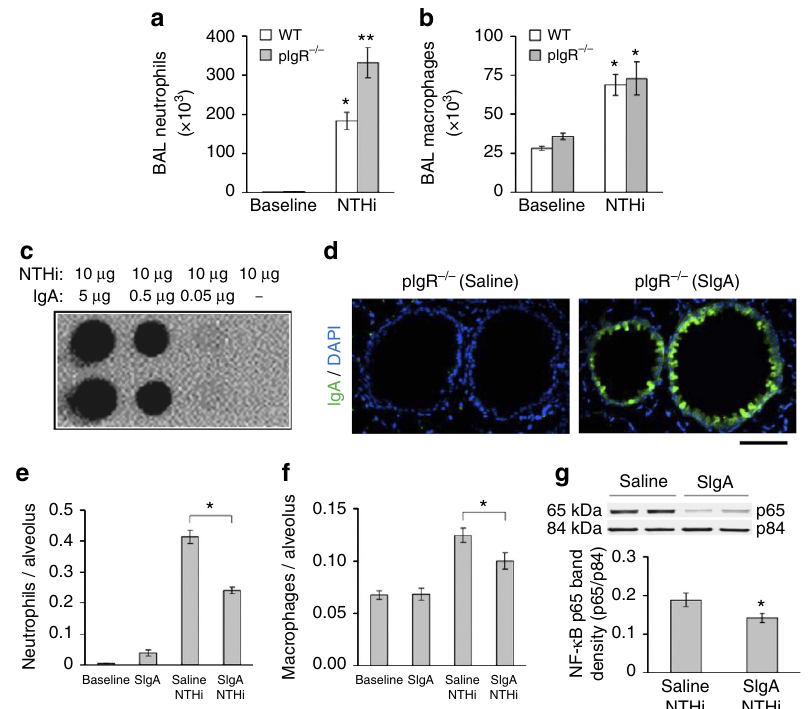
Figure 4 | SIgA modulates the acute inflammatory response to NTHi in vivo . ( a , b ) Neutrophil and macrophage counts in BAL fluid from 2-month-old WT and pIgR (cid:2) / (cid:2) mice 24h after aerosolization of NTHi lysate (10mg). Six to eight mice per group; * P o 0.01 compared with untreated mice (baseline), ** P o 0.01 compared with WT mice treated with NTHi (Student’s t -test). ( c ) Dot-blot assay demonstrating protein binding between NTHi lysates and human SIgA from colostrum. ( d ) Immunofluorescent detection of human SIgA (green) in the lungs of pIgR (cid:2) / (cid:2) mouse 1h after i.t. delivery of SIgA or vehicle (normal saline) (original magnification, (cid:3) 200). Scale bar, 50 m m. ( e , f ) Parenchymal neutrophil and macrophage counts 24h after aerosol delivery of NTHi lysate to 2-month-old pIgR (cid:2) / (cid:2) mice pretreated with i.t. SIgA (50 m l of 0.34mgml (cid:2) 1 solution) or vehicle (normal saline). Macrophage and neutrophil numbers were quantified by immunostaining for CD68 or NE, respectively. Five to six mice per group; * P o 0.05 compared with mice pretreated with saline followed by NTHi (Student’s t -test). ( g ) Western blotting and densitometry for p65 component of NF- k B (normalized to p84) in lung nuclear protein extracts from 2-month-old pIgR (cid:2) / (cid:2) mice pretreated with i.t. SIgA or normal saline 1h before NTHi nebulization and harvested 24h later. Six mice per group; * P o 0.05 (Student’s t -test).